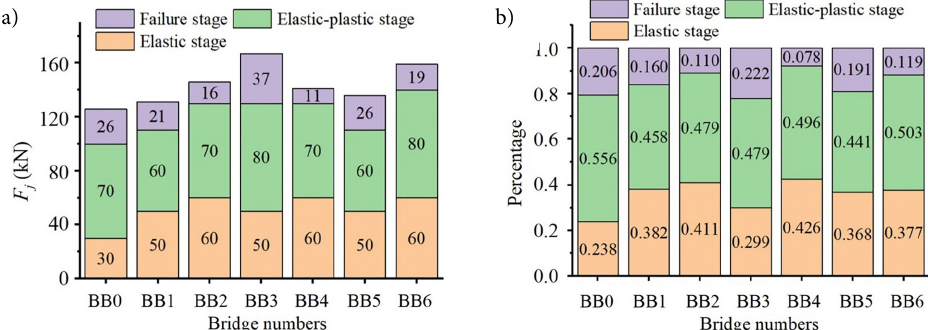
Figure 10. The E j -F j curves and in-plane bending moment with different beams of the mid-span cross section: a – The E j -F j curve; b – The in-plane bending moment